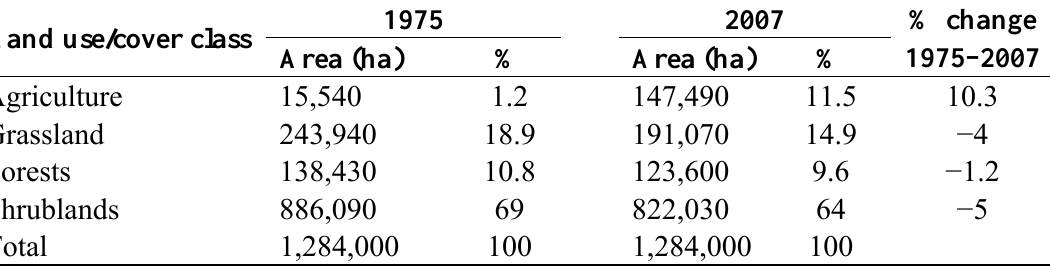
Table 3. Land use/cover changes in Masai Mara Ecosystem derived from satellite